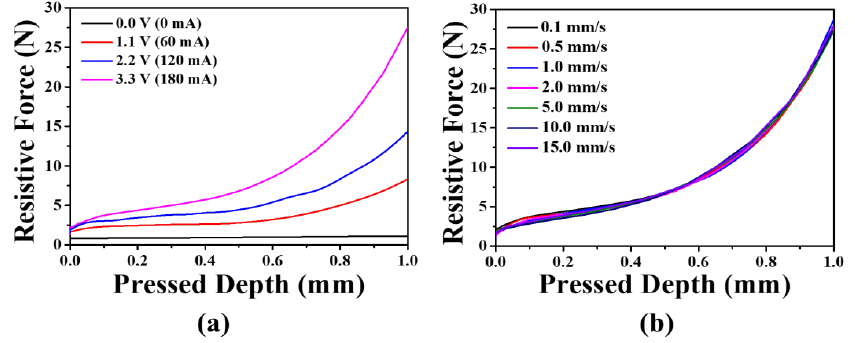
Figure 9. Measured resistive force by pressing depth with varying input current at a constant pressing speed of 0.1 mm/s ( a ) and with varying pressing speed at a constant input current of 180 mA ( b ).